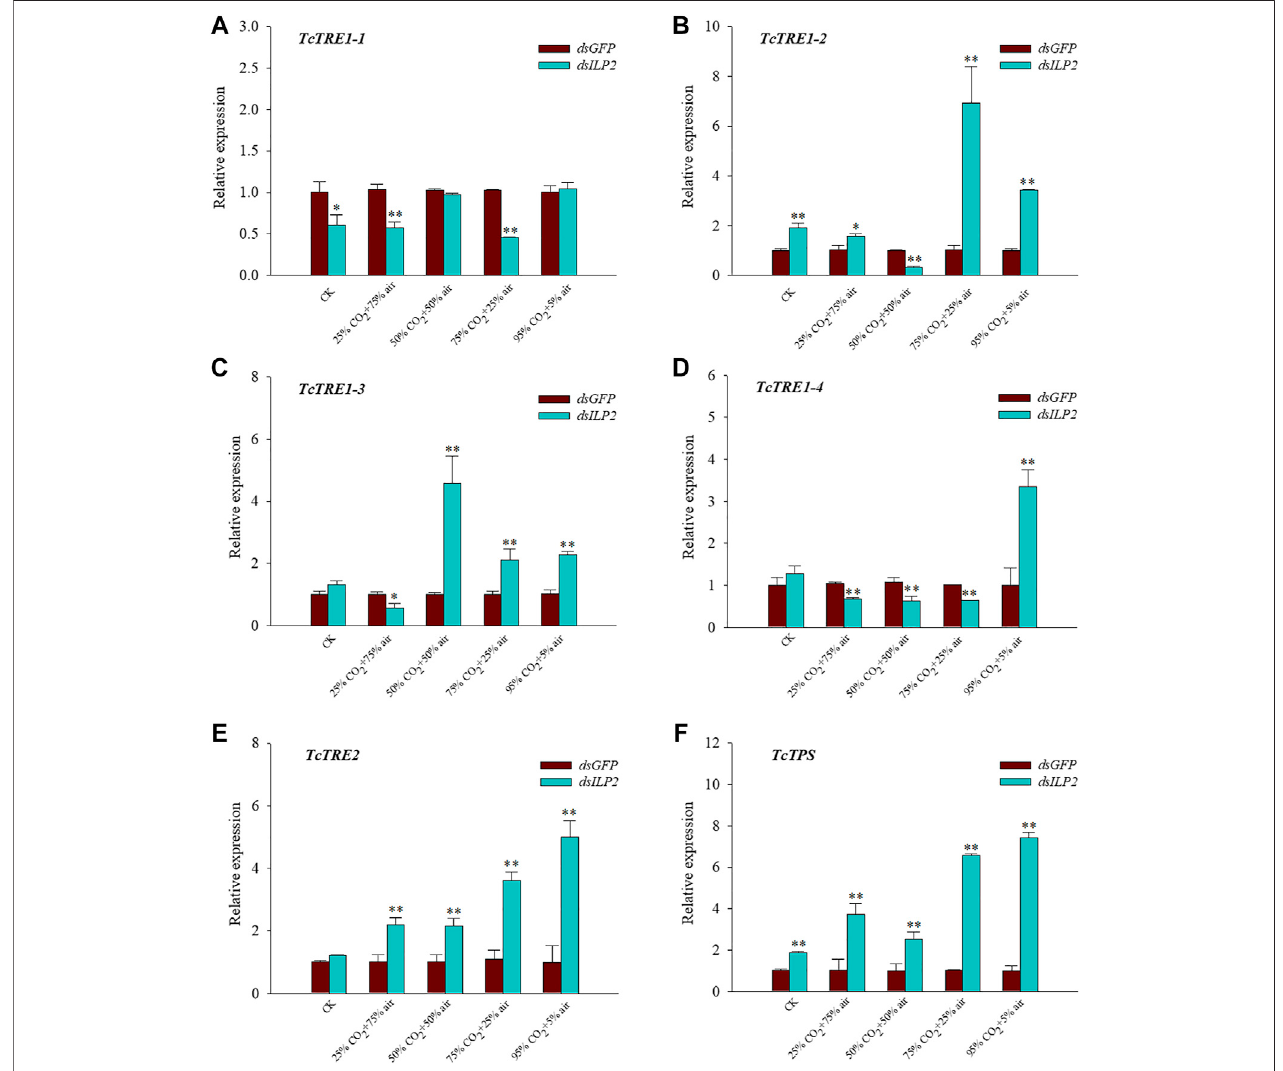
FIGURE 4| Effects of TcILP2 knockdown on the expressions of sixtrehalosemetabolic pathway genes. T. castaneum larvae were divided into three groups (each groupcovered10larvae)andinjectedwithdsILP2anddsGFP,and48 hcombinedwithtreatmentsof25%CO mRNA. Five trehalase genes including TcTre1-1 , TcTre1-2 , TcTre1-3 , TcTre1-4 , TcTre2 (A – E) and one trehalose-6-phosphate synthases gene [ TcTPS , (F) ].